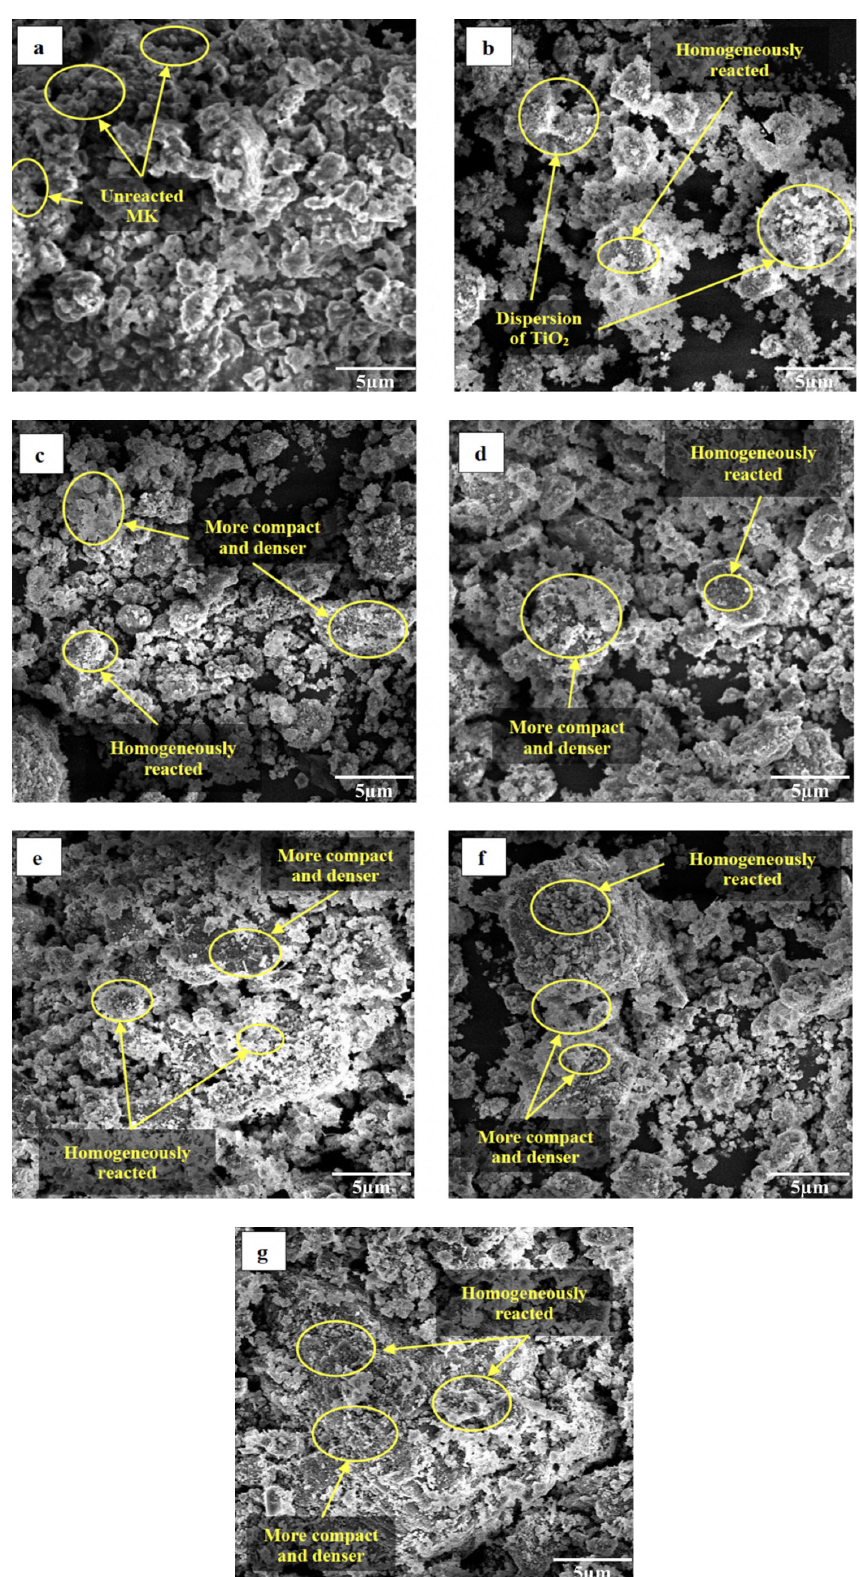
Figure 7. SEM images of metakaolin geopolymer coating: ( a ) GP; ( b ) GPTiO 2 ; ( c ) GPTiO 2